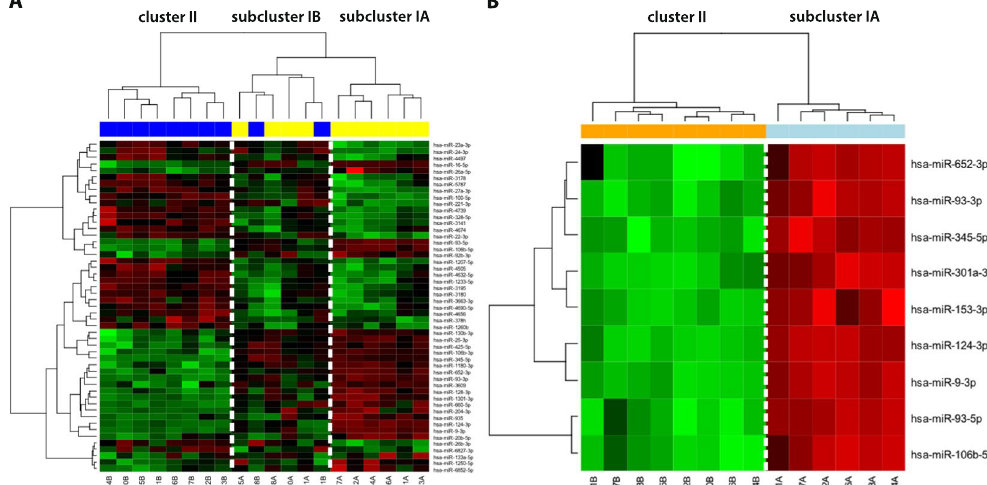
Figure 3. Hierarchical clustergram discriminating paired primary GSC (yellow) and non-stem glioblastoma cell cultures (blue) propagated in serum-free and serum containing medium, respectively. ( A ) Based on 51 differentially (P < 0.001) expressed miRNAs, ( B )Based on 9 miRNAs differentially (P < 0.0001) expressed in GSC and non-stem cell cultures contained in subclusters IA and II, respectively. A gradient of green and red colors is used in the heatmap (green color indicates lower expression whereas red color indicates higher expression of individual miRNAs in analyzed samples).